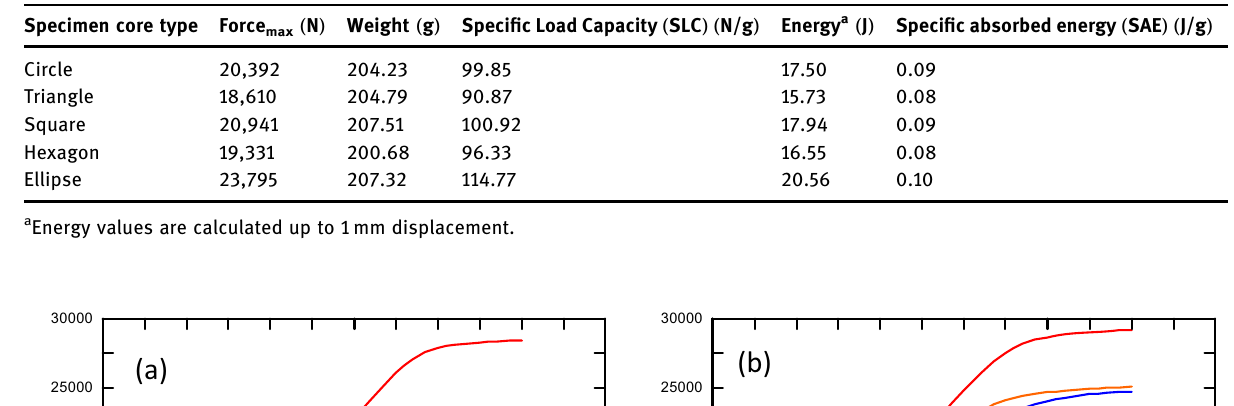
Table 3: Simulation results of the stainless - steel perforated sheet metal ( staggered arrangement ) obtained from fi nite element analyses